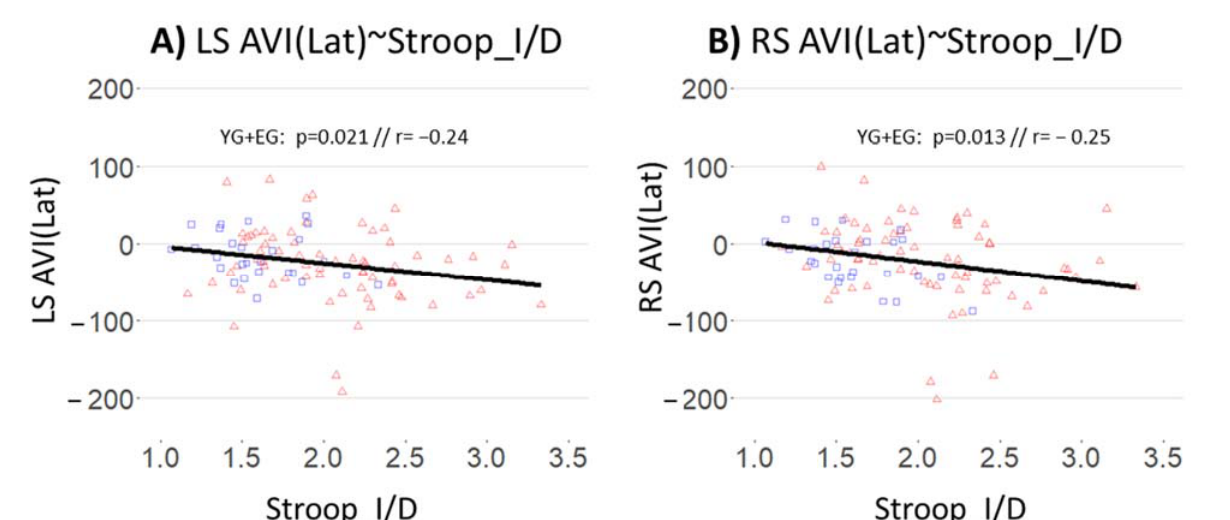
Figure 5. Correlations and regression lines between saccades AVI(Lat) and Stroop_D/I, for ( A ) Left Saccade and ( B ) Right Saccade, regarding the whole population (YG + EG). Blue squares represent the participants of the YG; red triangles represent the participants of the EG. The black solid line represents the regression line for the whole population (YG + EG). “r” represents the Pearson correlation coefficient and “ p ” represents the significance of the slope of the regression line.